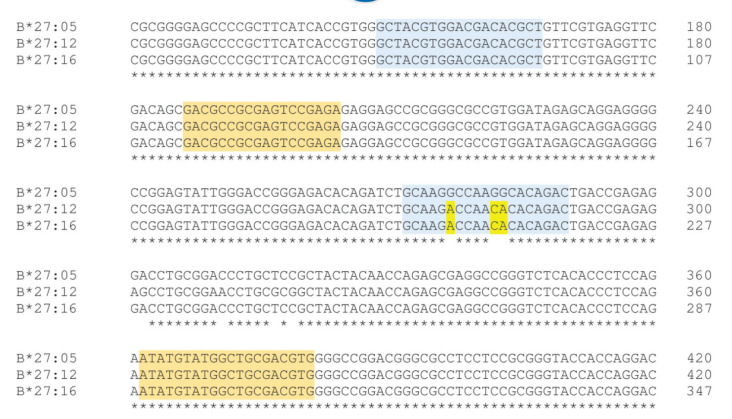
Clustal Omega multiple sequence alignment from the PCR-amplified regions of HLA-B*27:05, B*27:12, and B*27:16. The binding sites of SC1 and SC2 primer pairs are highlighted in light blue and orange, respectively. The yellow highlight indicates the divergent nucleotides.